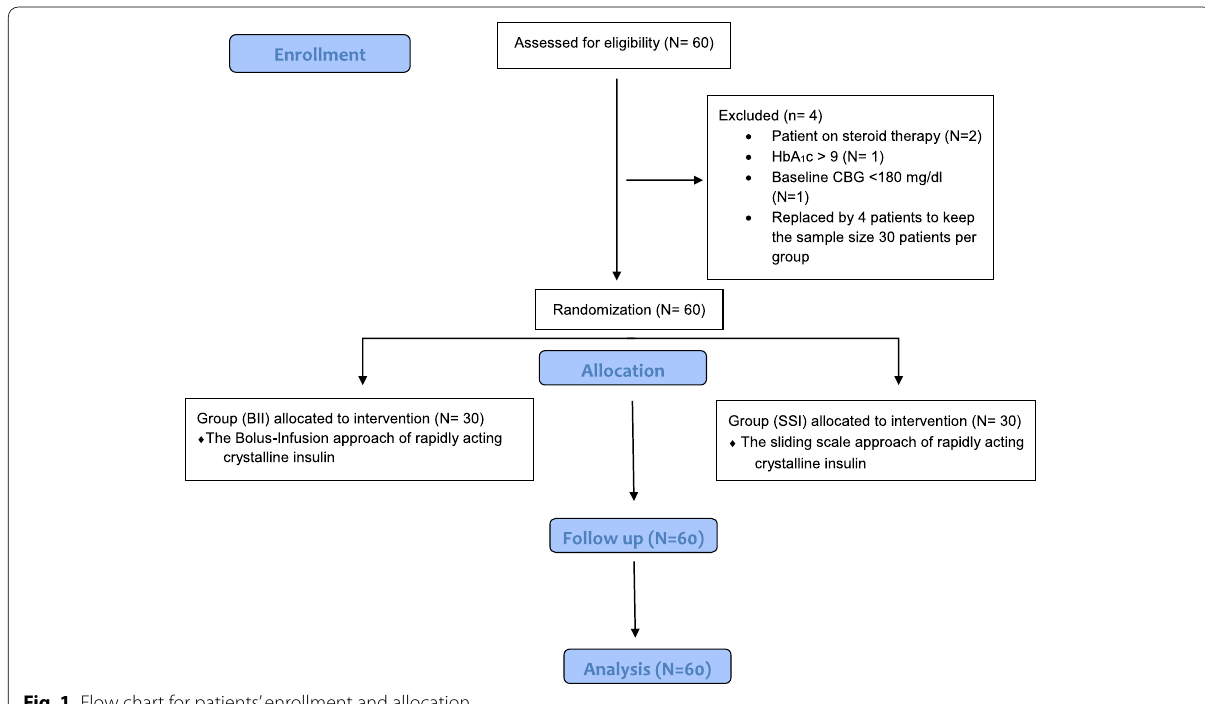
Fig. 1 Flow chart for patients’ enrollment and